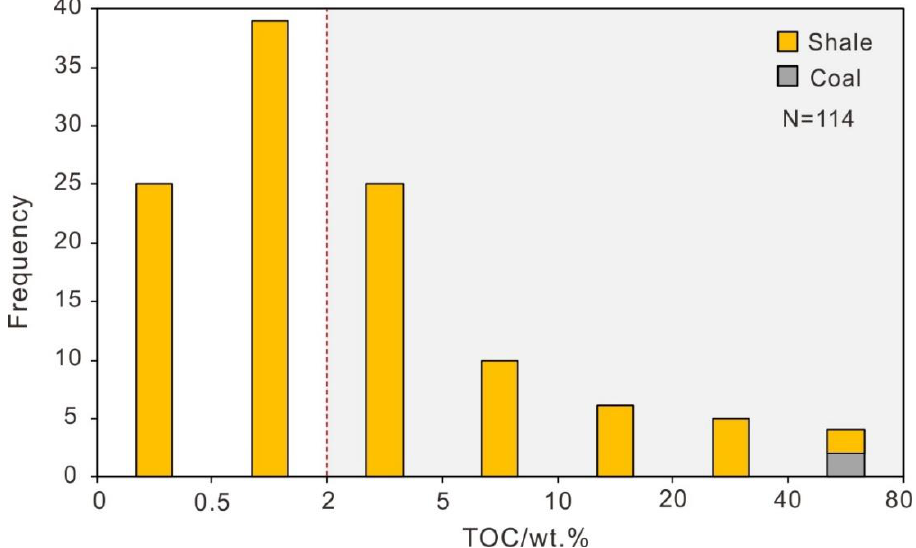
Figure 4. Frequency of distribution histogram of TOC of Longtan Formation mudstone in the Sichuan Basin.